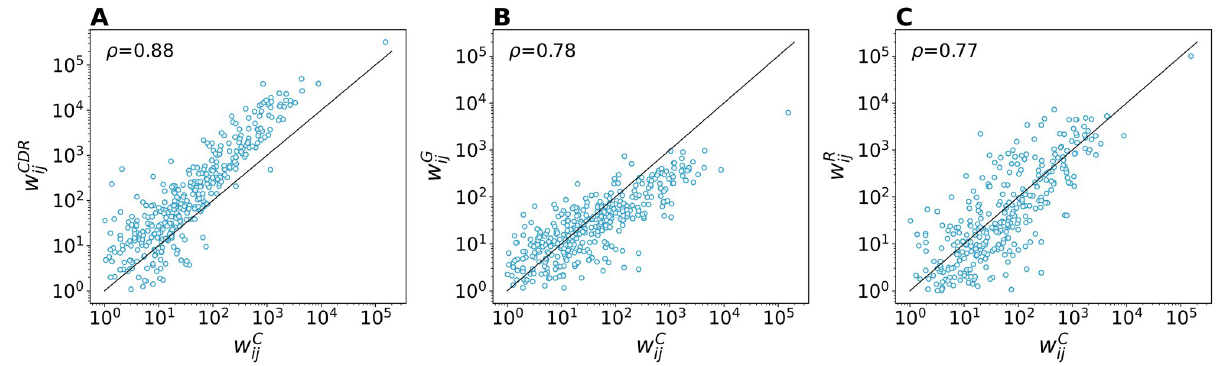
Fig 4. Comparison of mobility flows against the census network. Relationship between census flows w C informed network (A), gravity network (B), and radiation network (C). Spearman’s ρ correlation coefficient is reported.